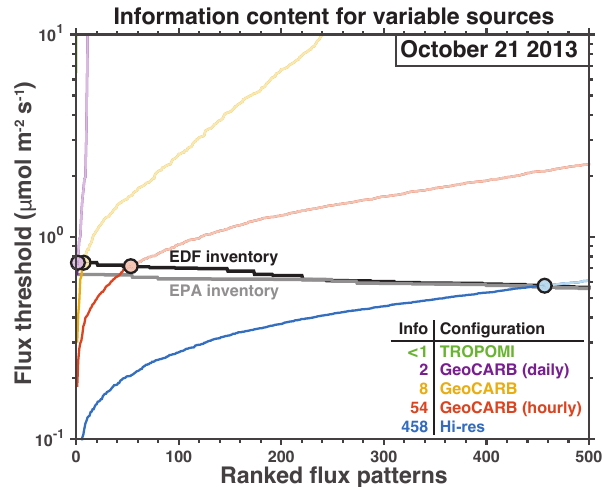
Figure 7. Same as Fig. 5 but for temporally variable sources on 21 October